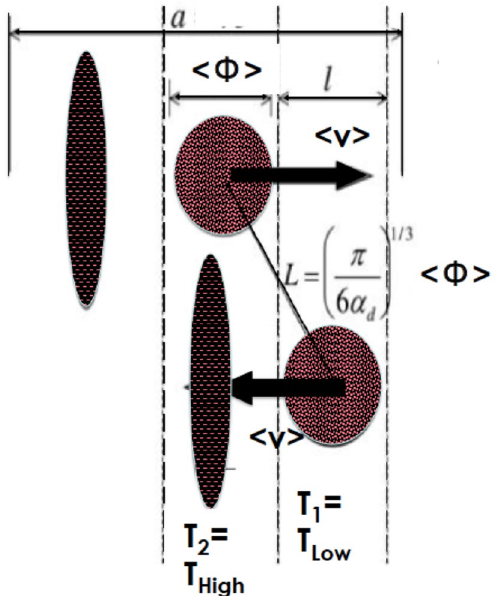
Figure 8. Schematic description and derivation of the Brownian component of the thermal conductivity of nanoparticles in a host fluid due to their Brownian motion 43–45